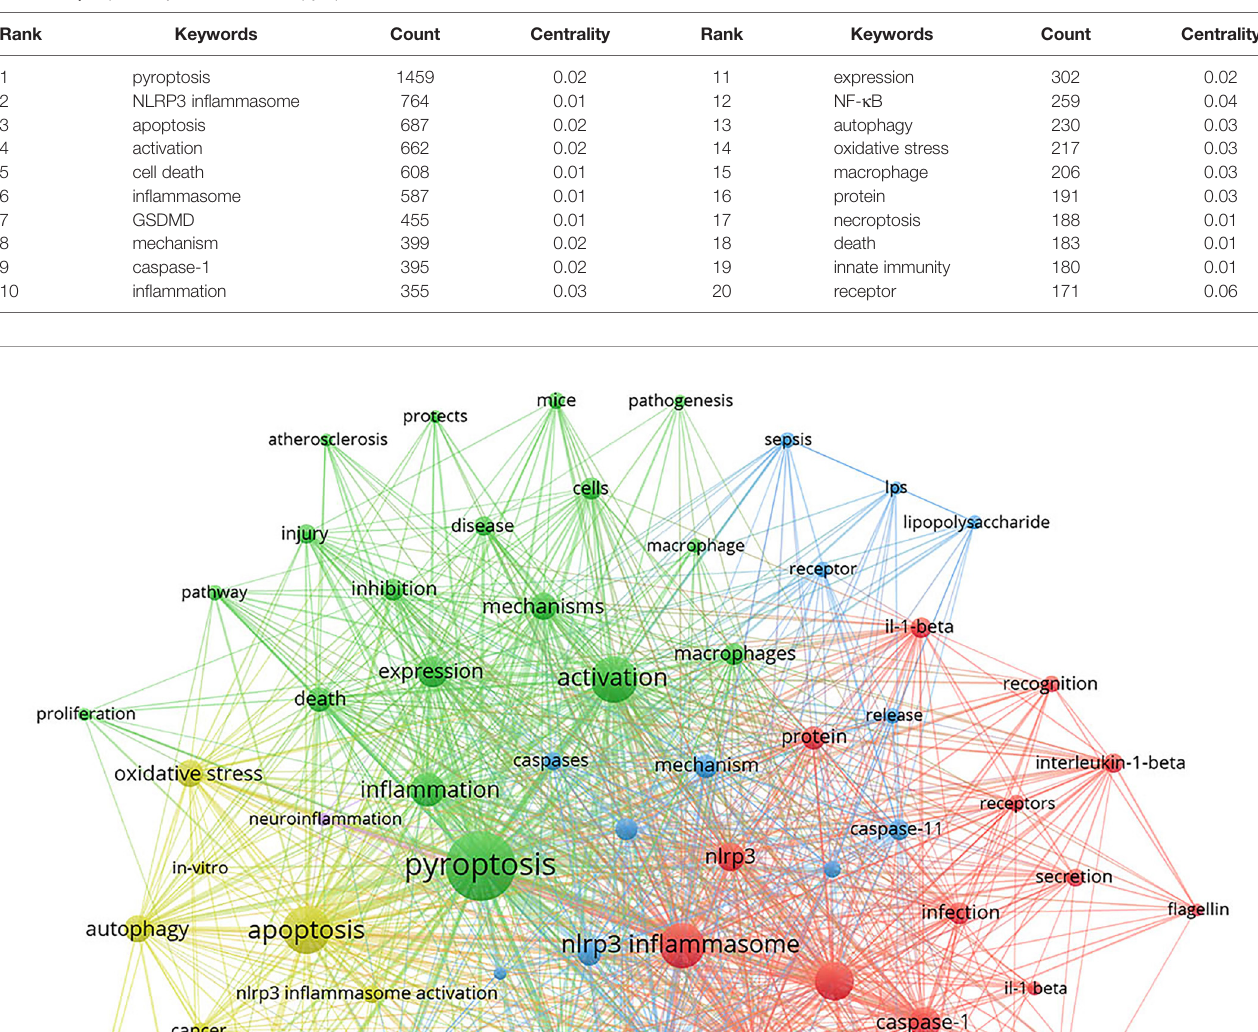
TABLE 5 | Top 10 keywords related to pyroptosis.